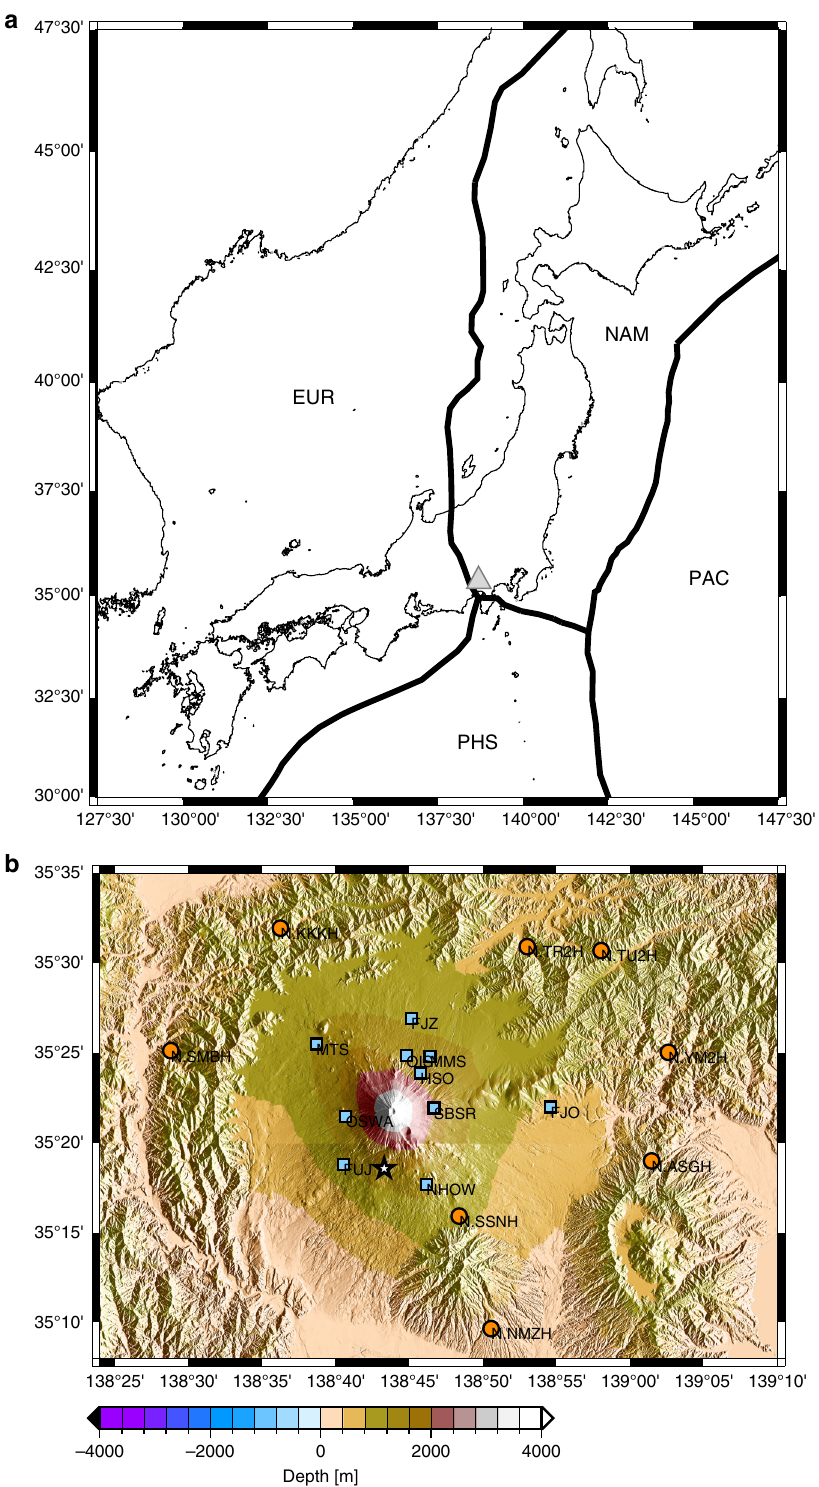
Fig. 1 Map of the study area: a Tectonic setting around Mount Fuji. Thick black lines, plate boundaries of the Philippine Sea Plate, the American Plate, the Okhotsk, and the Paci fi c Plate; triangle, location of Mount Fuji; star, hypocenter of the Tohoku-Oki earthquake. b Map of Mount Fuji with topography. Blue squares, seismic stations installed by the Japan Meteorological Agency, the National Research Institute for Earth Science, and the Earthquake Research Institute; orange circles, Hi-net stations installed by the National Research Institute for Earth Science 13 ; white star, epicenter of the Shizuoka earthquake; black square, meteorological station installed by the Hot Spring Research Institute of Kanagawa Prefecture. All of the seismic stations are equipped with three-component short-period sensors or broadband seismic sensors, with a sampling interval of 0.01